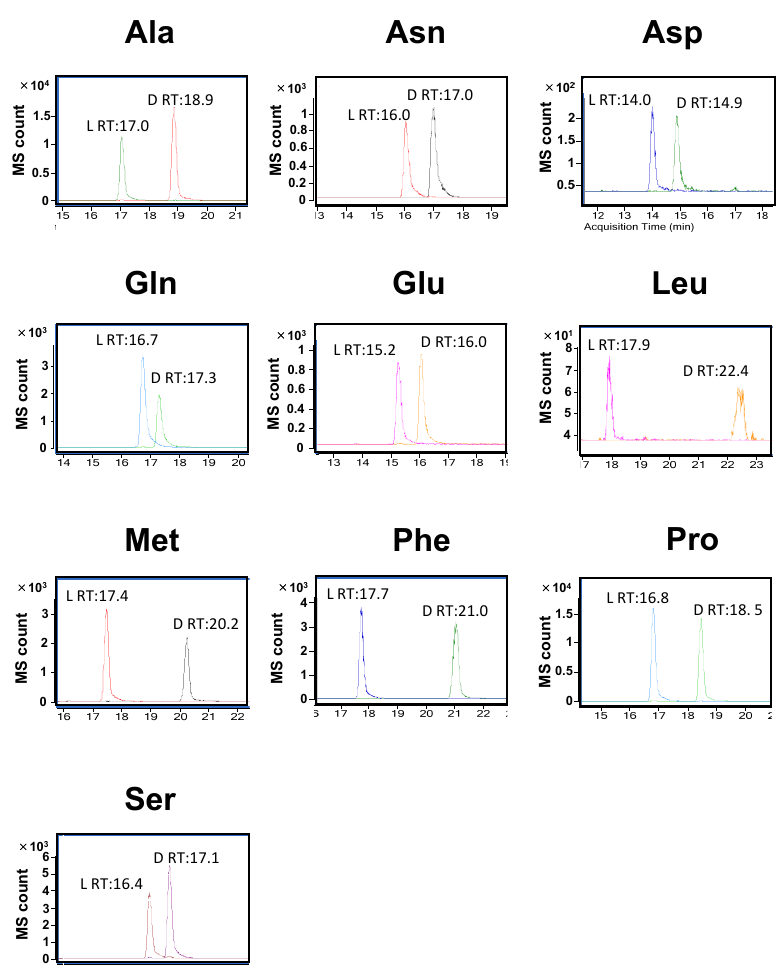
Figure 2. Chromatograms of standard compounds of derivatized L - and D -amino acids. Standard L - and D -amino acids were derivatized with L -FDLA and analyzed by LC/MS/MS. Representative MRM chromatograms of derivatized L - and D -amino acids are presented as merged to confirm the drift of retention time. In each panel, relative ion abundance (MS counts) versus retention time (min) are